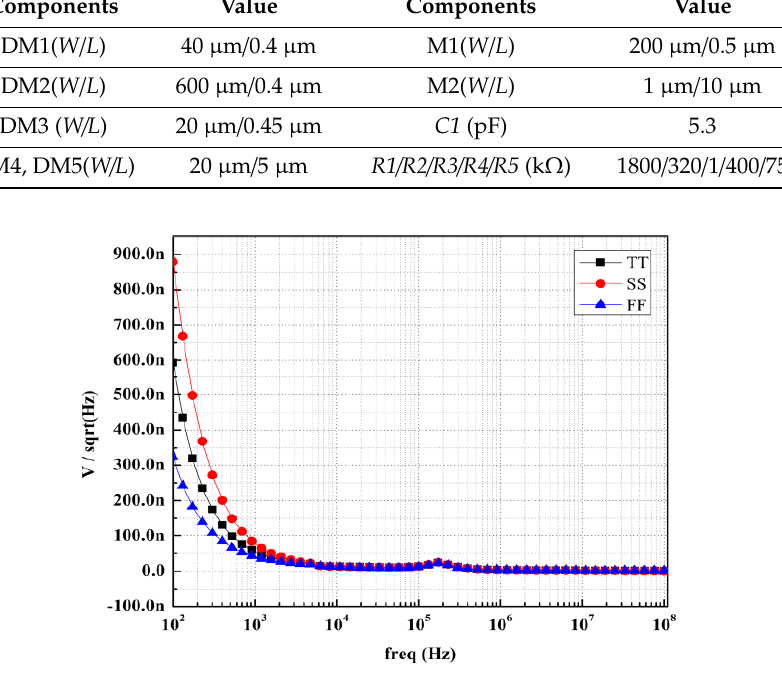
Table 1. Component sizes of the preregulator.